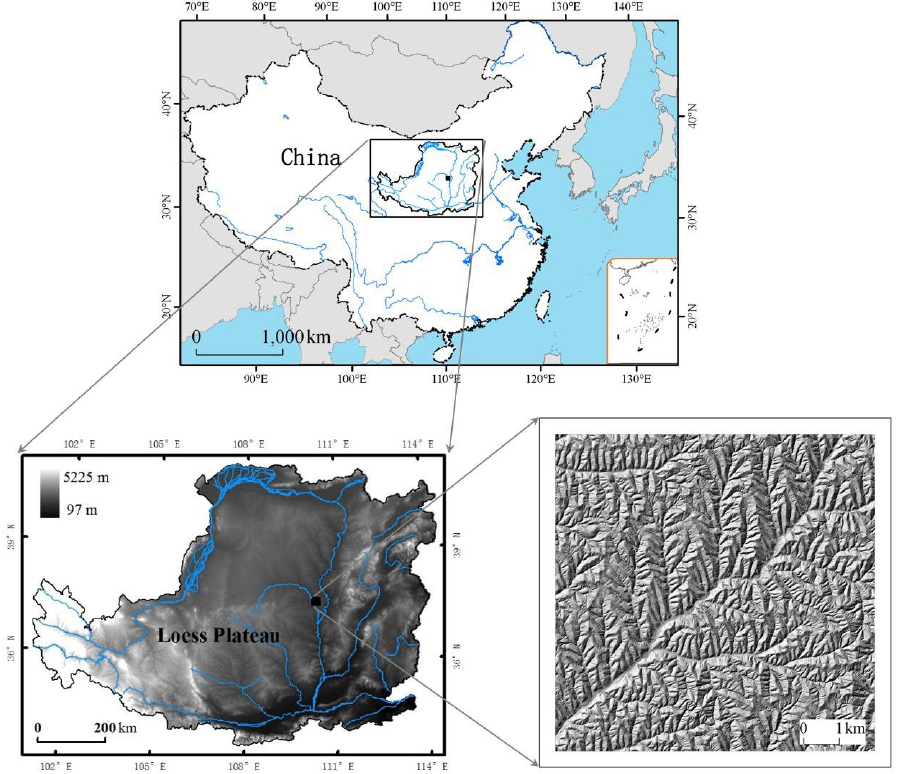
Figure 1. The location and terrain surface of the study area.